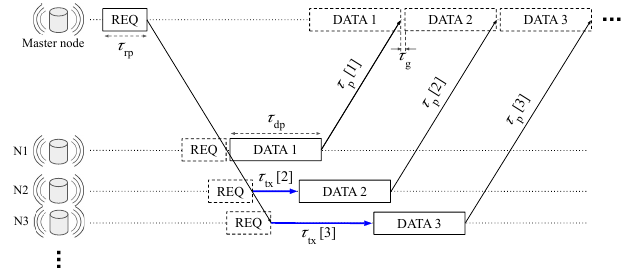
Figure 5. TDA-MAC packet flow [45]. The master node (gateway or relay) sends a broadcast “REQ” packet; when each sensor node receives it, it delays its packet transmission by an allocated transmit delay, which results in an efficient “packet train” reception pattern at the master